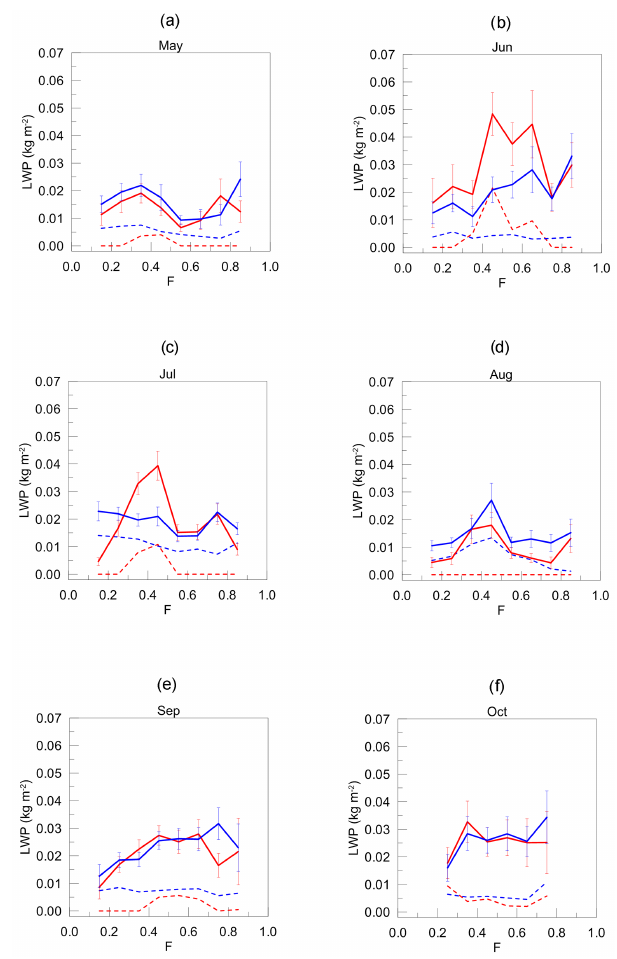
Figure 14. The mean (solid) and the median (dashed) LWP re- trieved from HATPRO (blue) and SEVIRI (red) as a function of a fraction of a day F for May, June, July, August, September, and October (the WH ensemble data), where the fraction of a day is a normalised period between SZA = 90 ◦ in the morning ( F = 0) and SZA = 90 ◦ in the evening ( F = 1). Error bars denote the standard deviation of the mean